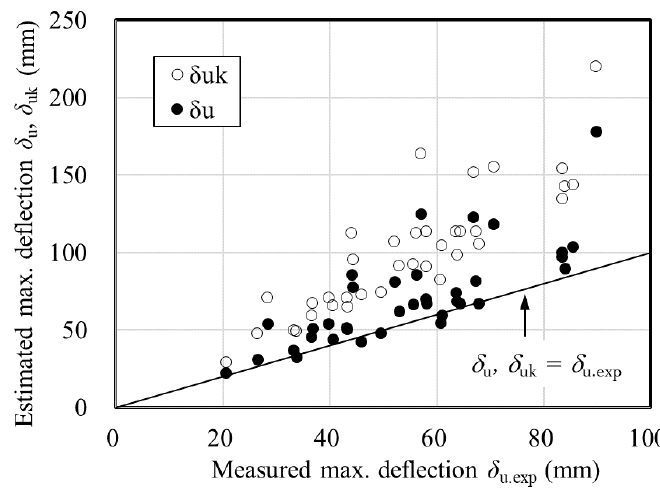
δ u and the measured value